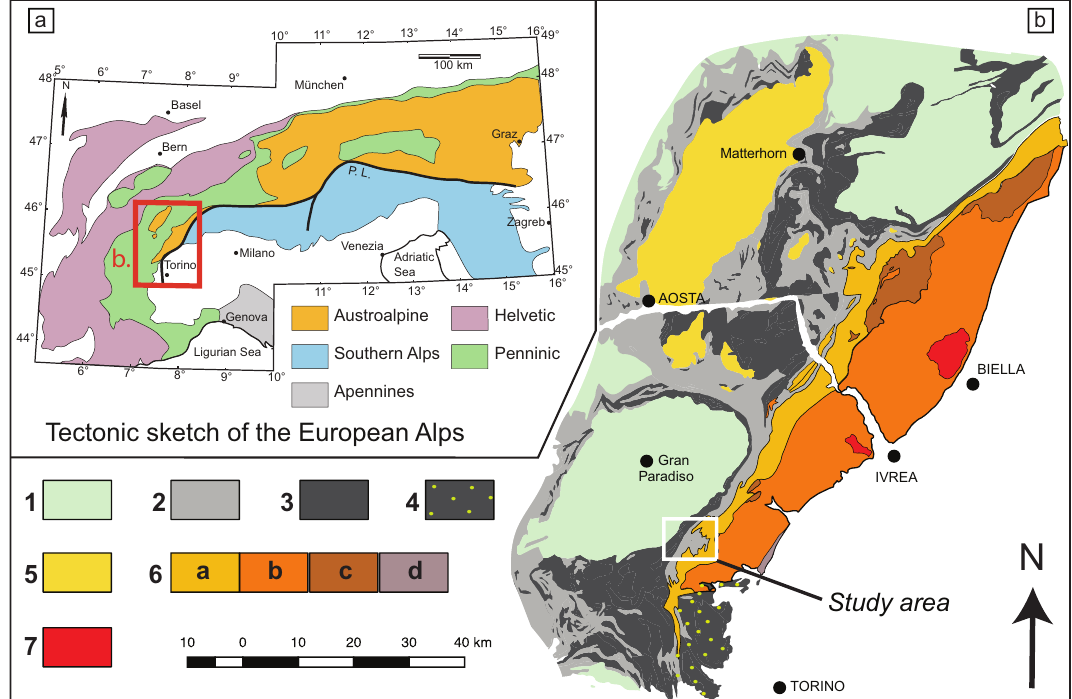
Figure 1. ( a ) Simplified tectonic scheme of the Alps with the different structural domains. The red rectangle locates the tectonic map in ( b ). P.L. = Periadriatic Lineament. ( b ) Simplified tectonic map of the Western Alps. The study area is located by the white rectangle (Figure 2). Legend: 1 = Penninic continental nappes; 2 = Piemonte Zone Mesozoic metasediments; 3 = Piemonte Zone metabasic and ultrabasic rocks; 4 = Lanzo Massif ultrabasics; 5 = Dent Blanche nappe and other Austroalpine continental klippen; 6 = Sesia-Lanzo Zone (Austroalpine Domain) - Gneiss Minuti Complex ( a ), Eclogitic Micaschists Complex ( b ), II Dioritic-Kinzigitic Zone ( c ) and Rocca Canavese Thrust Sheets ( d ); 7 = Tertiary Plutons (Biella and